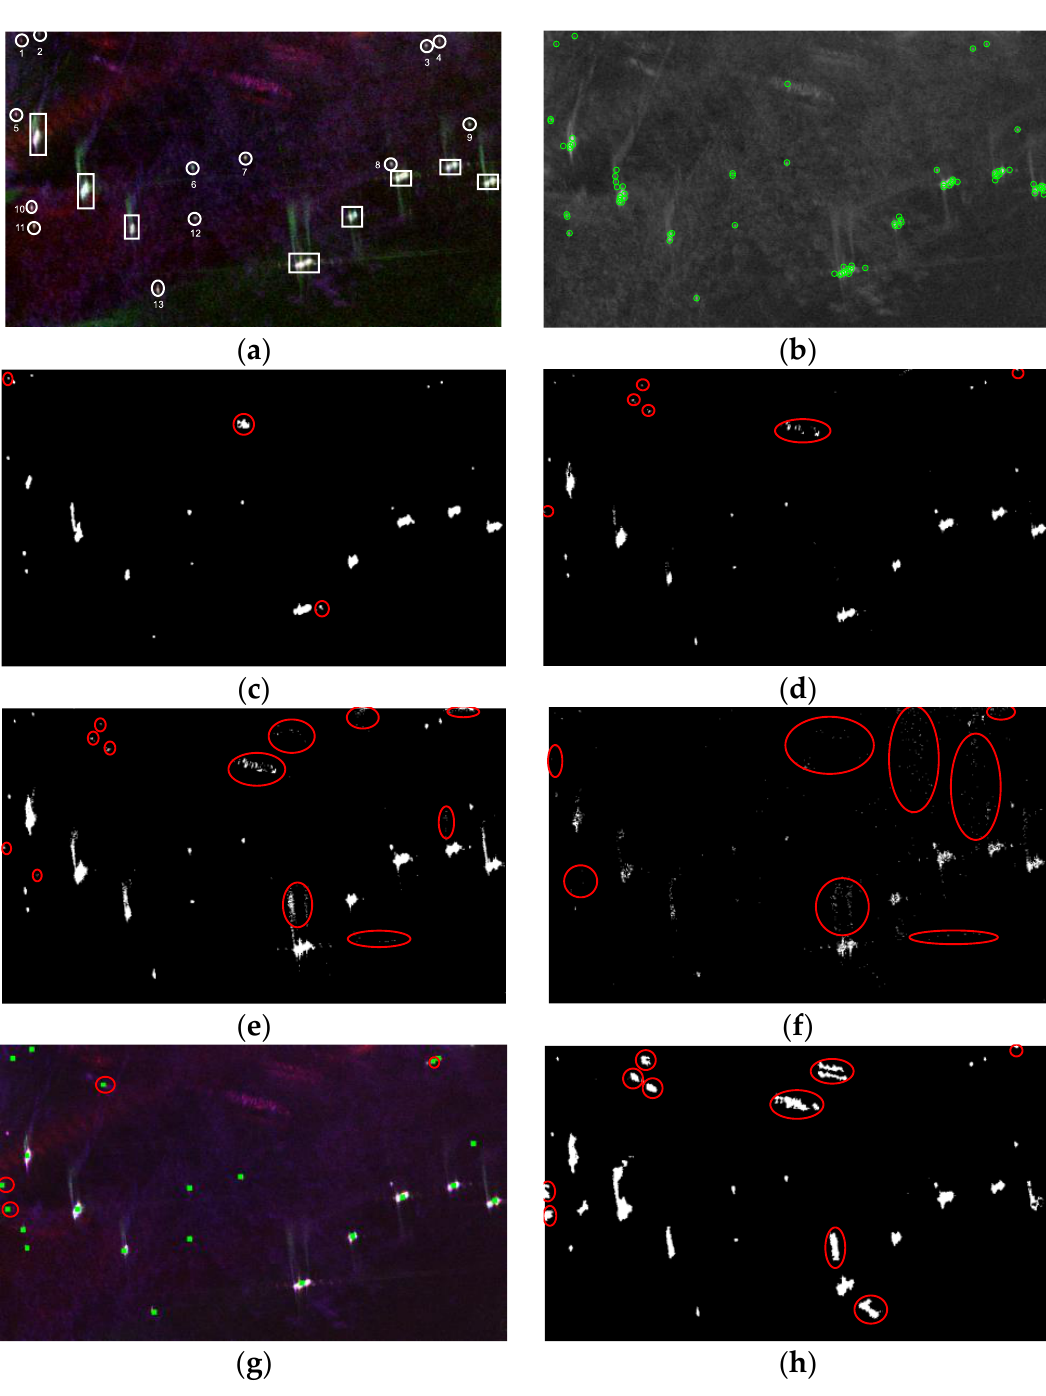
Figure 12. R4 regions: ( a ) Pauli pseudo-color image with potential targets manually marked. White rectangles indicate the strong targets and white ellipses indicate the comparatively weak targets. ( b ) Keypoints extracted by PolSAR-SIFT keypoint detector. ( c – h ) Detection results of the proposed method, the PNF, the PWF, the RS, the SD-LSMDRK and the SD-SLLIM, respectively. The main false alarms are marked by the red circles.